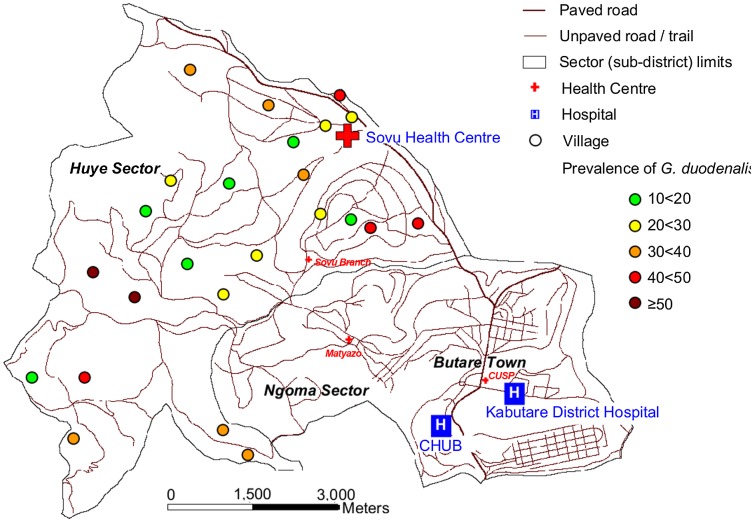
Distribution of Giardia duodenalis in children <5 years of age in Huye sector, Rwanda.